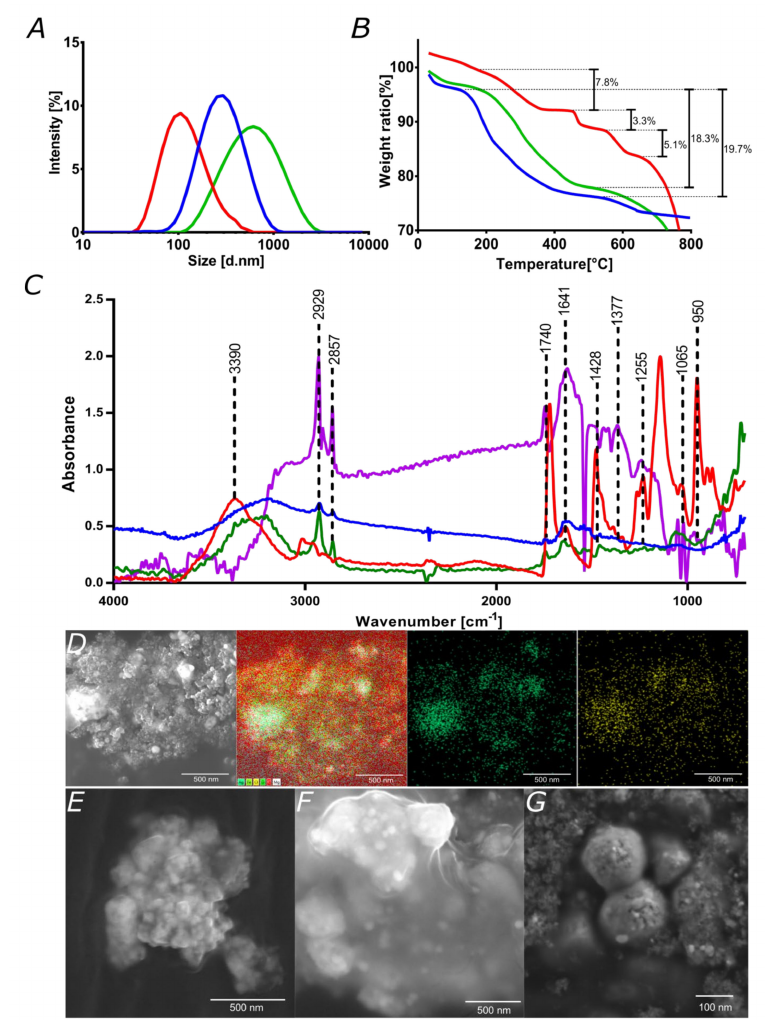
Figure 4. Characterization of nanoconjugates and nanobioconjugates. ( A ) Nanoparticles size distribution using Dynamic Light Scattering for magnetite (red), magnetite / silver (blue), and magnetite / silver- pDMAEMA-PEA-BUFII (green). ( B ) TGA analyses of magnetite (green), magnetite / silver (blue), and magnetite / silver-pDMAEMA-PEA-BUFII (red); percentage of weight loss are presented in each case. ( C ) FTIR spectra of bare pDMAEMA (Red), magnetite / silver (Blue), magnetite / silver-pDMAEMA (green) and magnetite / silver-pDMAEMA-PEA-BUFII (purple). Peaks at 1740 and 1428 cm − 1 are for C = O and -N(CH 3 ) 2 bonds of conjugated pDMAEMA while peaks at 1641, 1377, and 1255 cm − 1 correspond to amide I and α helix, stretching vibration of the N-C bond, and the amide II, respectively, of the conjugates BUF-II. Peaks 1065 cm − 1 and 950 cm − 1 are for the Si–O–Si (due to silanization) and Fe–O bonds of the magnetite core. ( D ) SEM image of magnetite / silver nanoparticles. The silver shell and the success of the chlorination reaction were verified through EDS analysis. The EDS map shows silver in green and chlorine in yellow, which superimposed and confirmed that chlorination was completed to a large extent. Scale bar corresponds to 500 nm. ( E ) SEM image of the core magnetite nanoparticles as synthesized by co-precipitation (Scale bar corresponds to 500 nm). ( F ) SEM image of magnetite / silver-pDMAEMA shows the e ff ective coating of nanoparticles by the polymer. Scale bar corresponds to 500 nm. ( G ) Magnetite / silver-pDMAEMA-DNA after loading in bu ff er at pH 7 (scale bar corresponds to 100